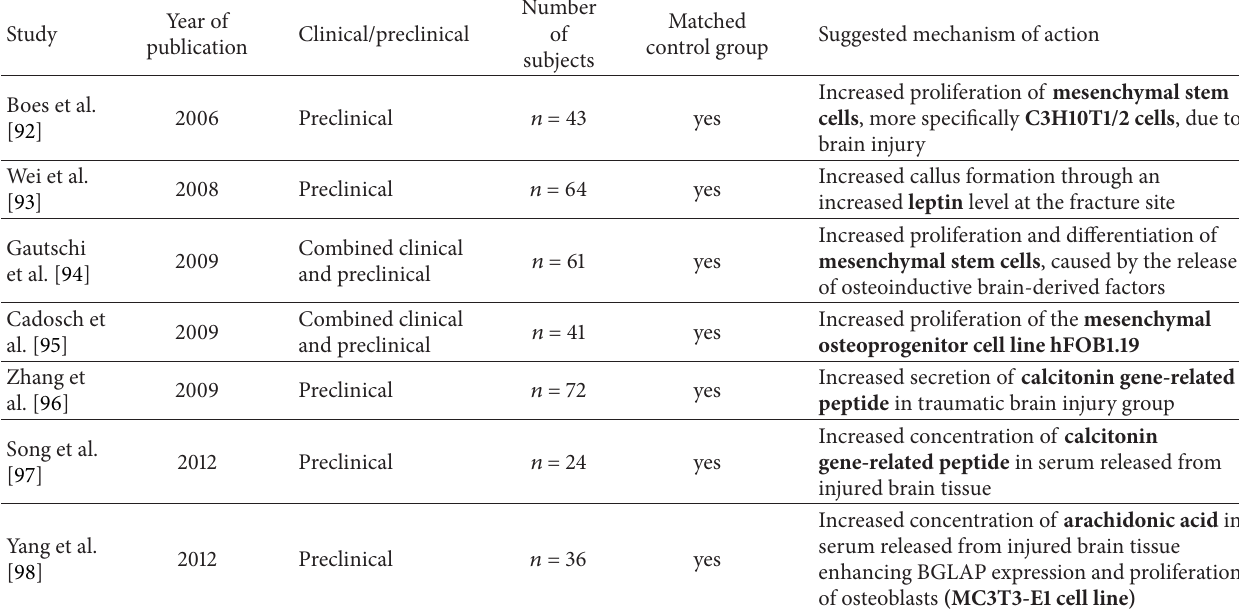
Table 2: Studies with evidence for a certain mechanism of